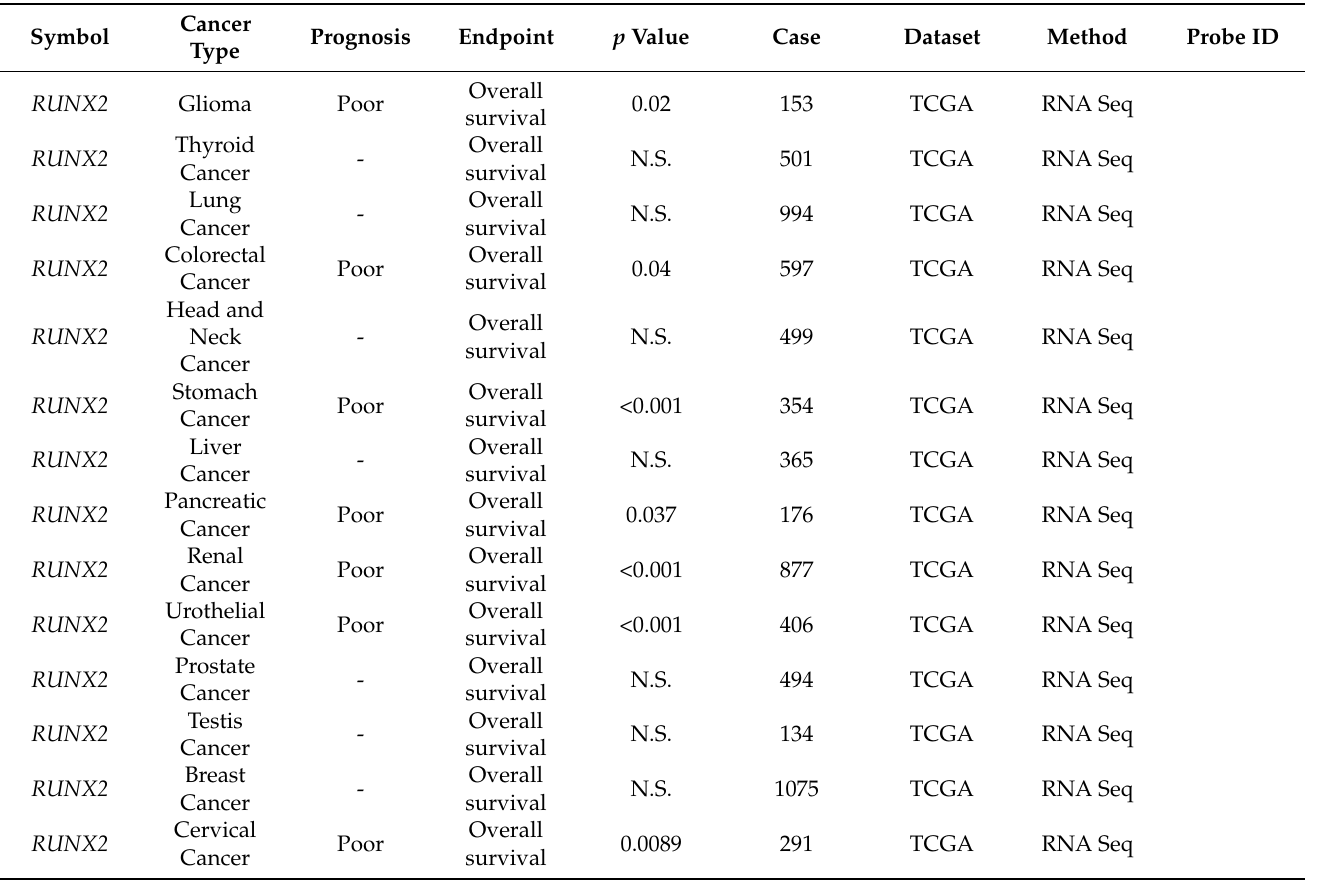
Table 2. Correlation of RUNX2 with cancer patient